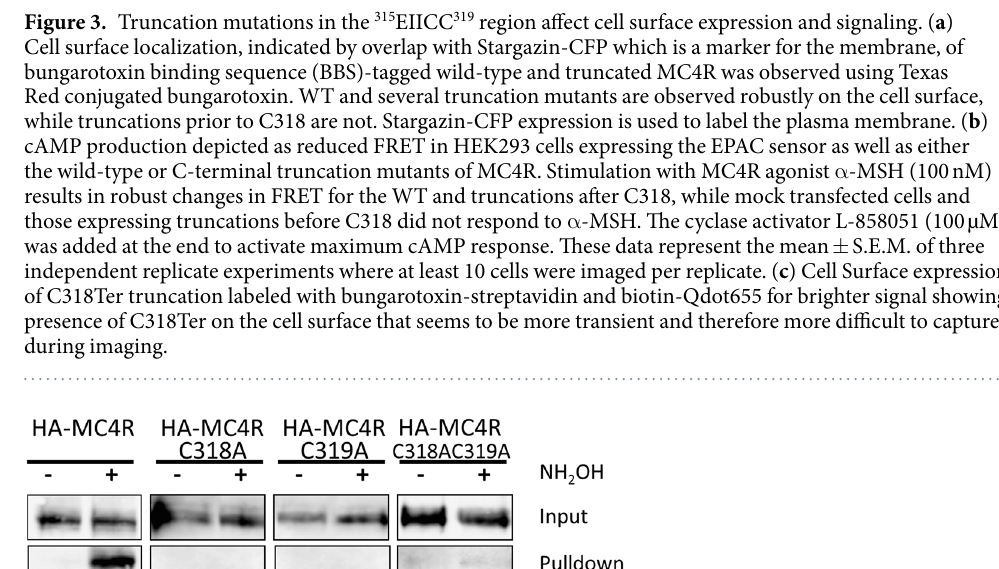
heterozygous knockout mice show similar low levels of weight gain when fed a low-fat chow and heterozygous mice under these conditions are only mildly overweight 34 . We therefore speculate that the overweight, non-obese Q307Ter carrier may be protected from severe obesity by lifestyle or environmental factors. Similarly, the over- weight L328Ter fits well with the norm of our cohort, which has a median BMI of ~31, where many genetic and